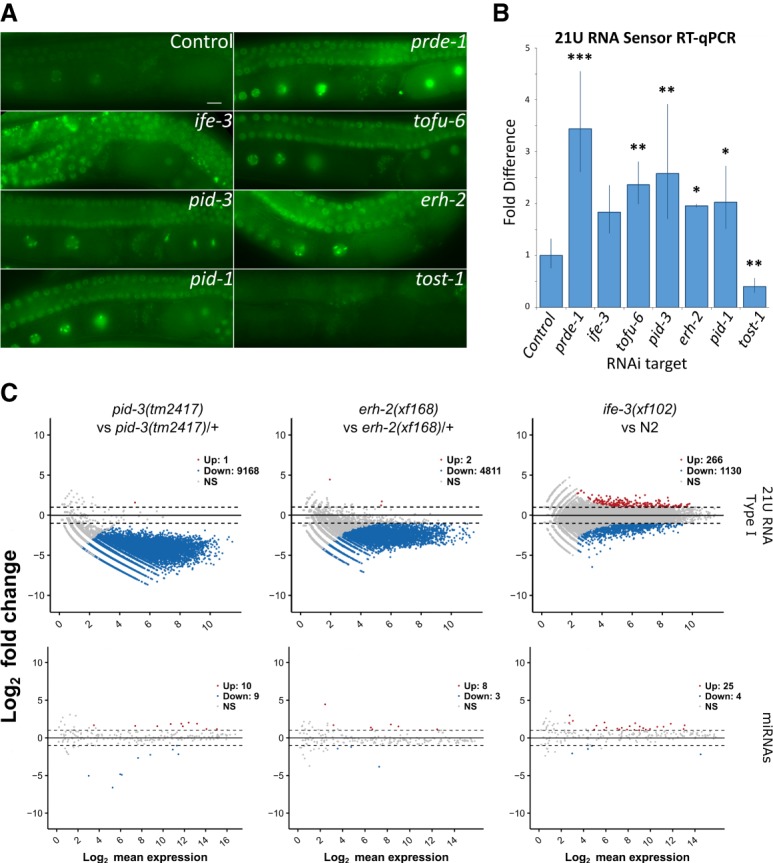
PETISCO is required for 21U RNA biogenesis. (A) Wide-field fluorescent microscopy of adult hermaphrodites carrying the GFPH2B-21U sensor transgene in a sensitized background. Worms were subjected to RNAi via feeding (targets are indicated) from L1 larval stage to adulthood. Empty RNAi vector served as a negative control. Scale bar, 10 µm. (B) Quantitative RT-PCR of the 21U sensor transgene in the adult worm populations of A. Values were obtained from experimental triplicates and technical duplicates, normalized to pmp-3 mRNA levels. The significance of sample versus control was tested with Dunnett's post hoc test. (***) P-value < 0.001; (**) P-value < 0.01; (*) P-value < 0.05. Error bars represent standard deviation. (C) Pairwise differential gene expression of type I 21U RNAs and miRNAs in pid-3(tm2417), erh-2(xf168), and ife-3(xf102) versus the respective controls. Samples consisted of nongravid adult individuals. Red and blue dots indicate up-regulated and down-regulated transcripts, respectively.